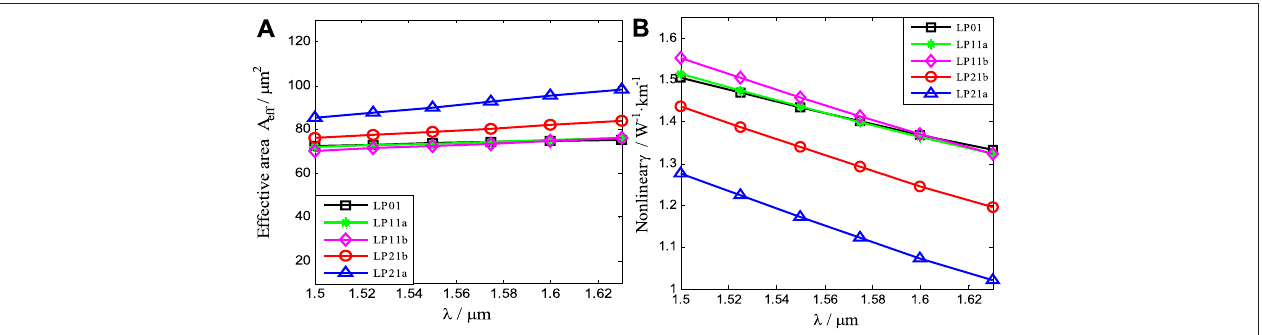
FIGURE 6 | Variations of the effective mode fi eld area A eff (A) and the non-linear coef fi cient γ (B) with input wavelength. The solid lines with squares, stars, diamonds, circles, and triangles in Figure (A) represent the effective areas of the modes LP01, LP11a, LP11b, LP21b, and LP21a, respectively. The solid lines with squares, stars, diamonds, circles, and triangles in Figure (B) represent the non-linear coef fi cients of the modes LP01, LP11a, LP11b, LP21b, and LP21a, respectively.